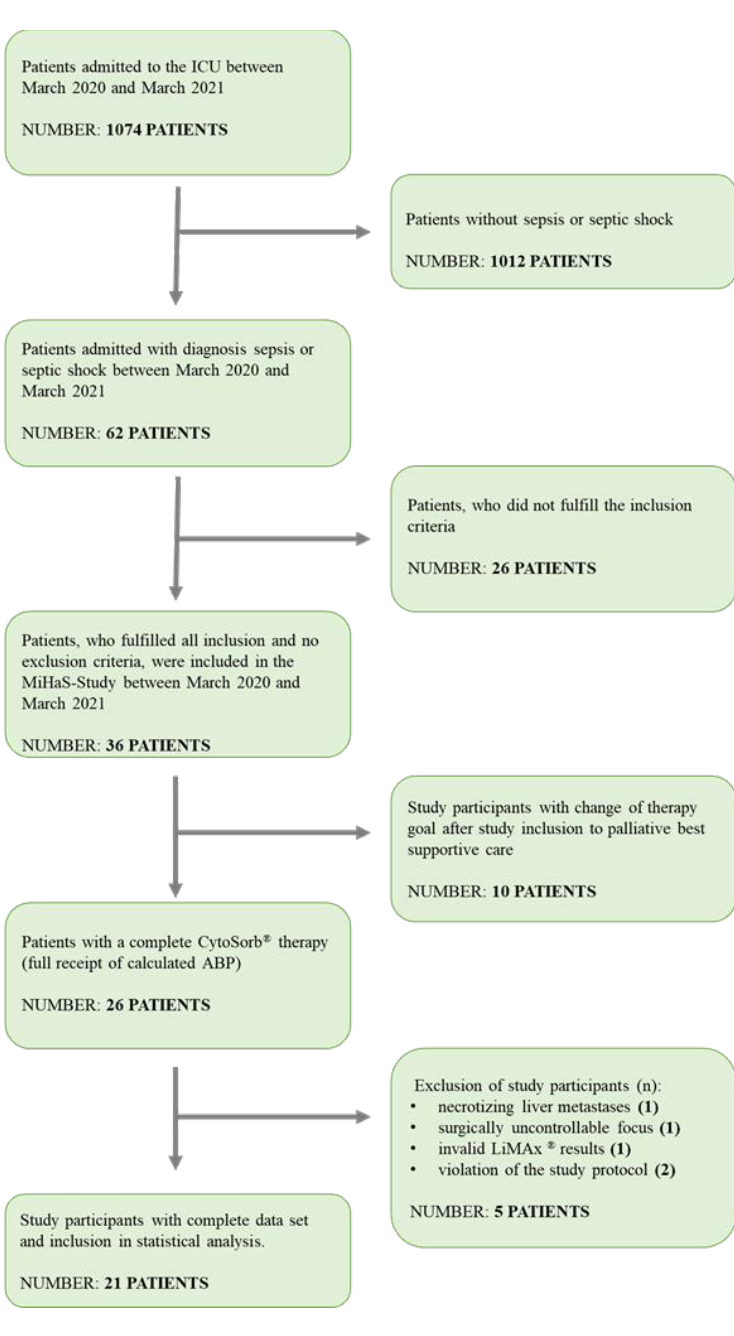
Figure 1. CONSORT statement.